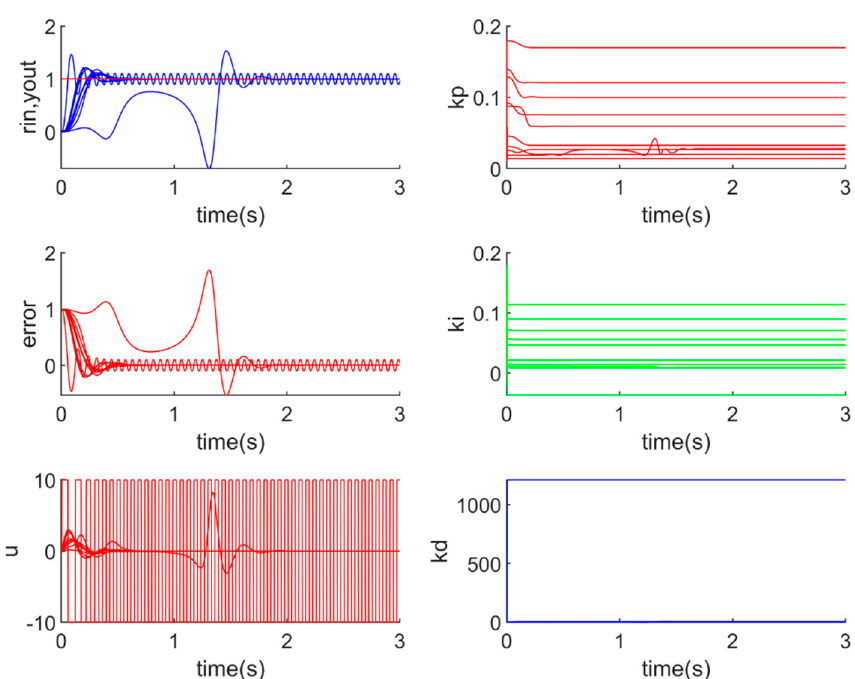
Figure 11. 10 SCs simulation for unstable RBFNN-PID systems.